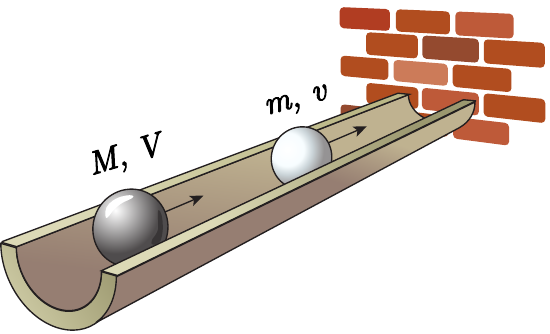
Figure 2. Schematic picture of a billiard system, consisting of a heavy ball M , light ball m and a